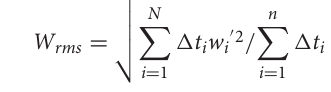
the acrylic channel is utilized. On the top of the test section a water tank is installed where water flows away from the three circumferential